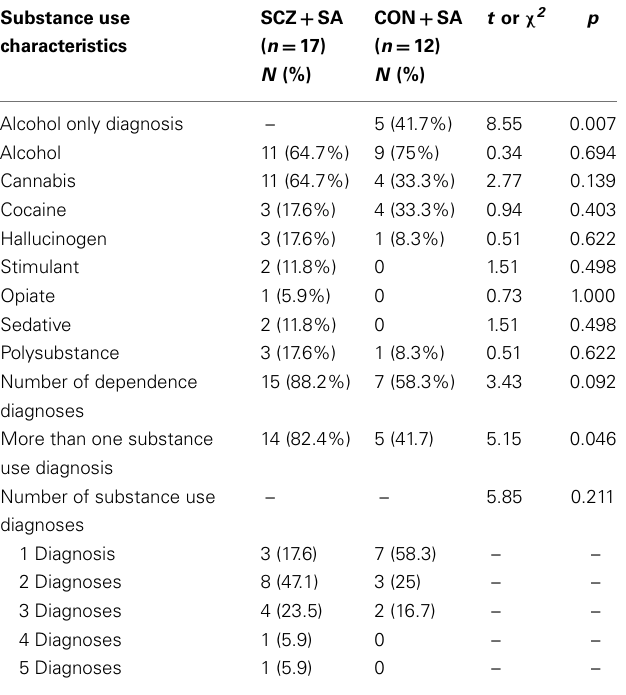
Table 2 | Past substance use diagnostic characteristics of the schizophrenia and control participants .